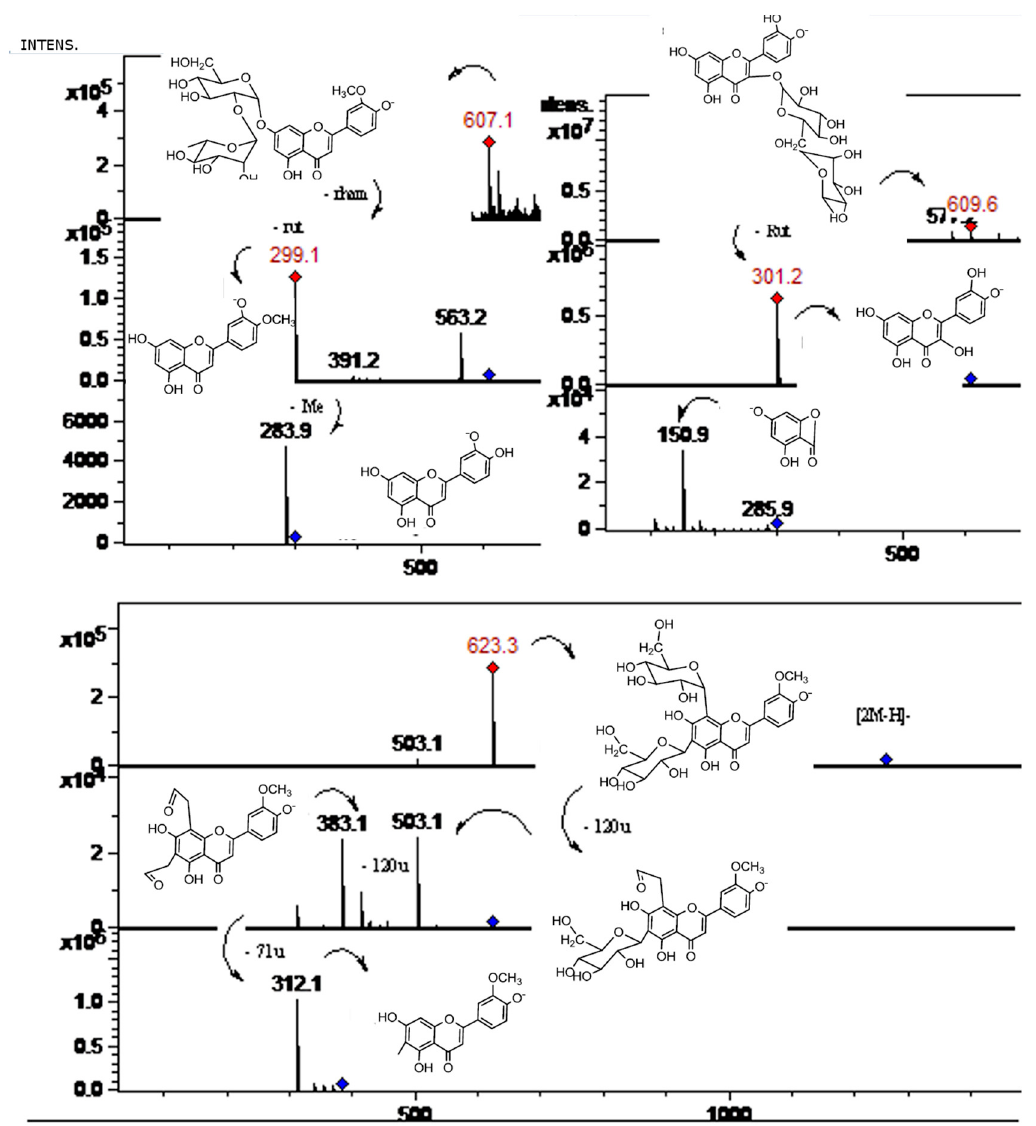
Figure 9. MS spectra of peaks 7 , 8 , and 19 . (Refer to Table